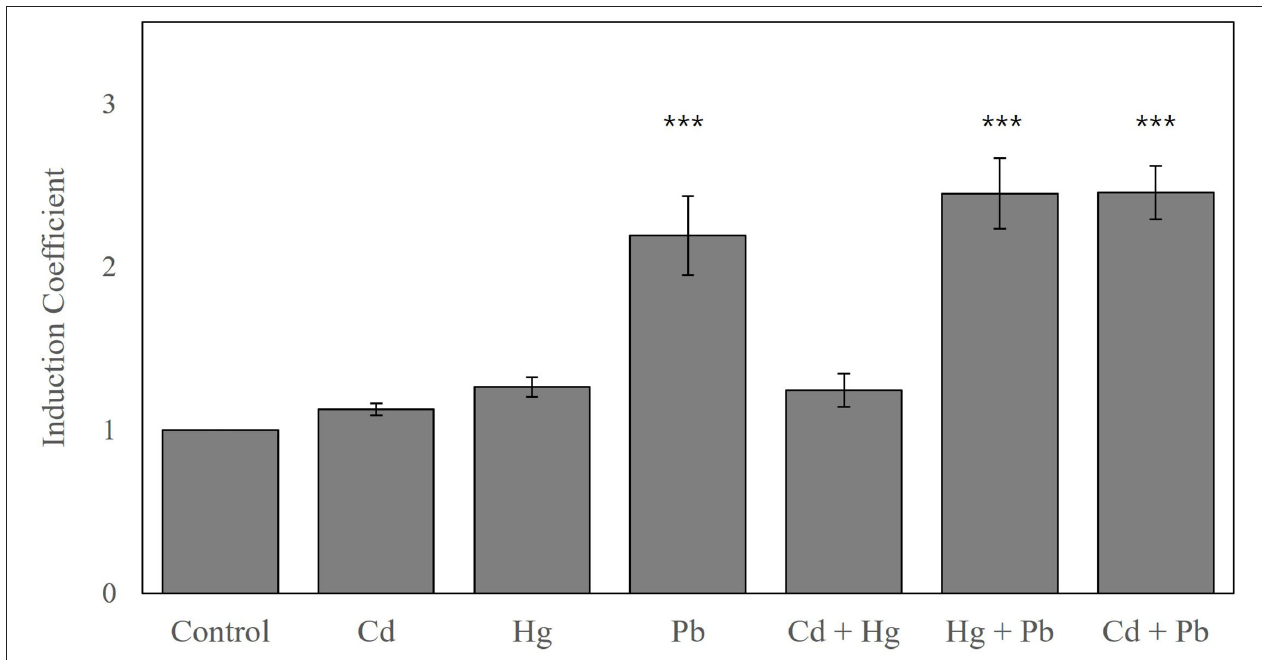
FIGURE 5 | The comparative and combined exposures of biosensors E. coli-zntR/copA/zntA harboring pZnt-eGFP and ZntR C115I to Pb(II), Cd(II), and Hg(II). The biosensors were exposed to 10nM of metal ions comparatively and combinedly, and the responses were represented as induction coefficient values. The asterisk means the data were significantly higher than the control (Dunnett’s test, *** p < 0.001).